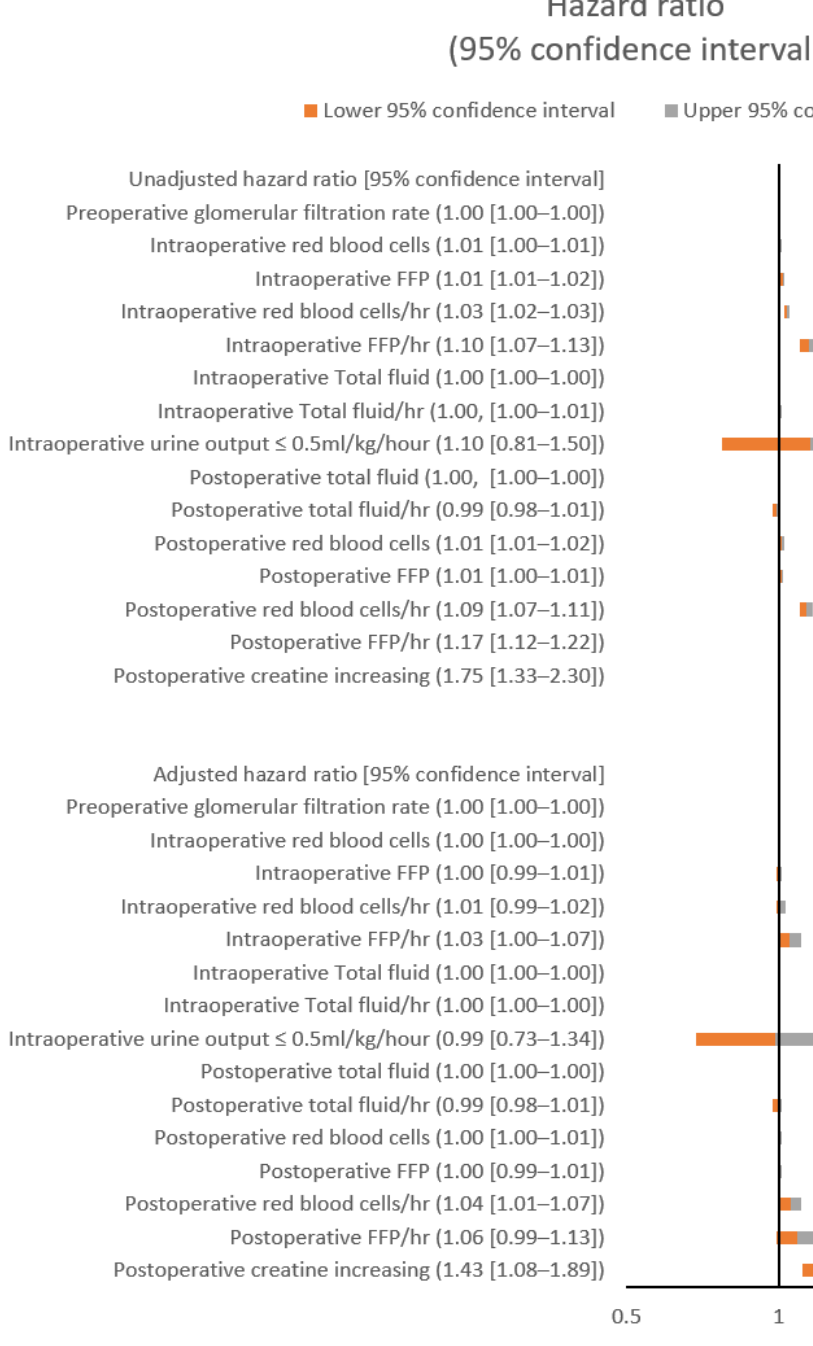
Figure 2. Unadjusted and adjusted hazard ratios for postoperative pulmonary edema with hypoxemia. FFP: fresh frozen plasma.